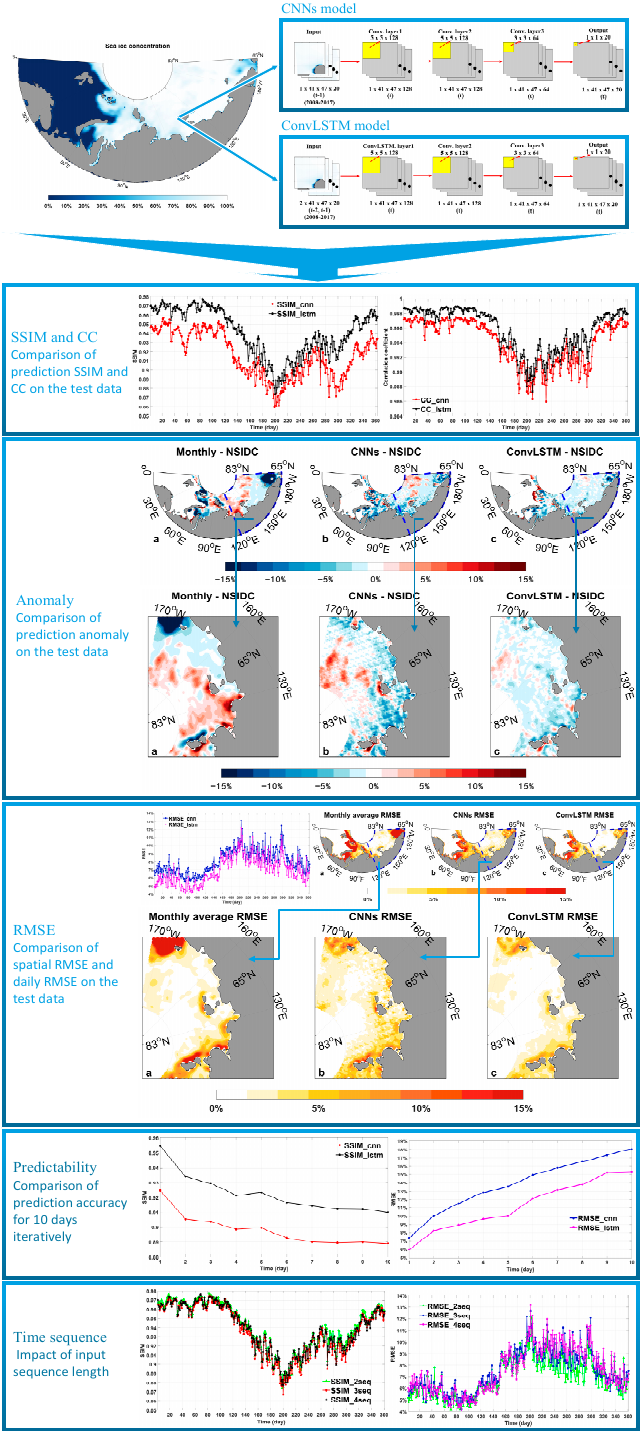
Figure 5. Model and research